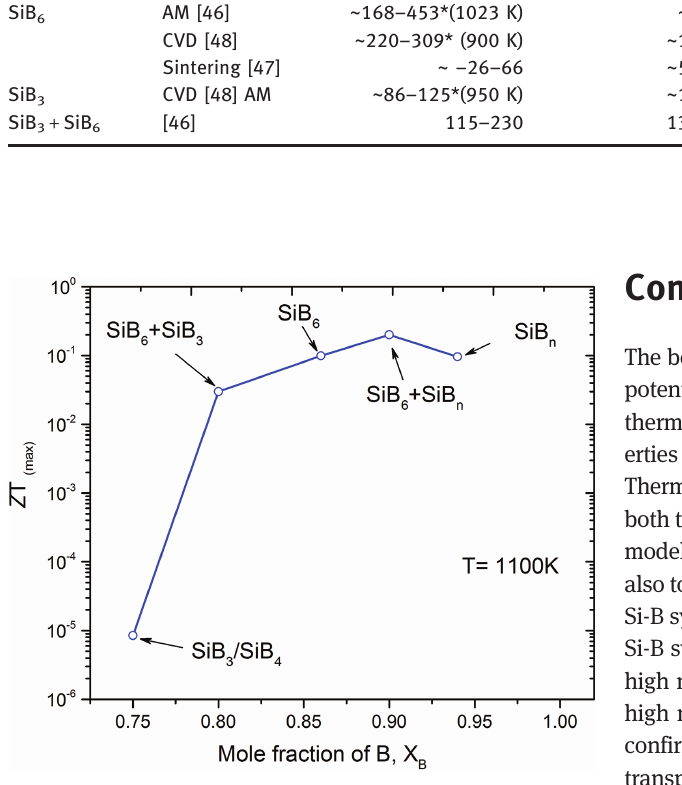
Figure 11: Boron content dependence of figure of merit (ZT).